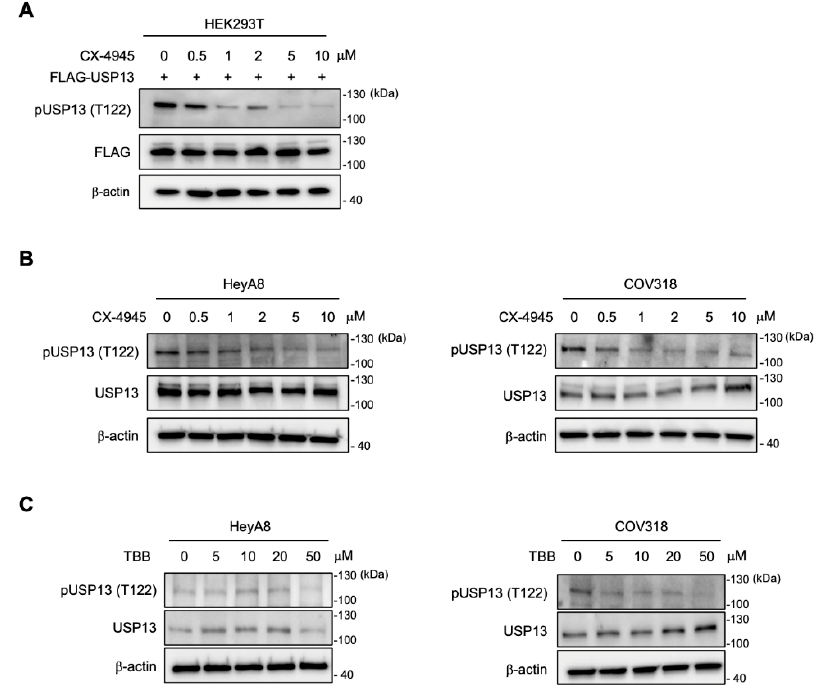
Figure 5. Inhibition of CK2 decreased USP13 phosphorylation at Thr122. ( A ) Immunoblot analysis of HEK293T cells expressing FLAG-USP13 after treatment of CX-4945 for 24 h. The treatment of CX-4945 dramatically reduced the level of Thr122 phosphorylation. β -actin was included as a loading control. ( B ) Treatment of CX-4945 (for 24 h) and ( C ) TBB (for 48 h) reduced phosphorylation of endogenous USP13 at Thr122 in two different human ovarian cancer cells; HeyA8 (left) and COV318 (right).